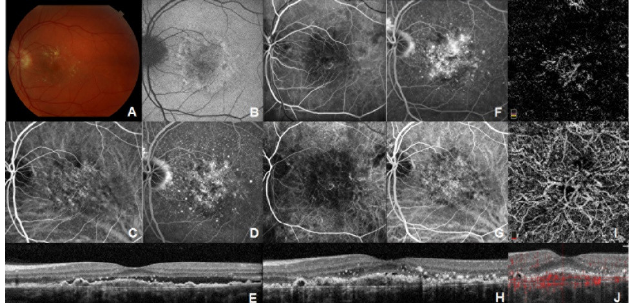
Figure 1. Multimodal imaging of one patient with subthreshold CNV. ( A ) Fundus photography of the left eye with soft drusen and pigmentary changes. Visual acuity (VA) is 20/25. ( B ) Diffuse ring of hyperautofluorescence is noted in the macula. ( C ) ICGA does not demonstrate a clear hot spot or plaque. ( D ) Late phase FA shows diffuse staining corresponding to RPE atrophy and drusen. ( E ) SD-OCT demonstrates irregular RPE elevation with overlying SRF. Fifteen months later, VA decreased to 20/70. ( F ) Early ( left ) and late ( right ) frames of FA demonstrate diffuse leakage of undetermined source in the left eye. ( G ) ICGA reveals a hypercyanascent neovascular membrane in both early ( left ) and late ( right ) phase. ( H ) SD-OCT demonstrates a fibrovascular pigment epithelial detachment (PED) with overlying hyperreflective spots and sliver of SRF. ( I ) Corresponding OCT-A of the outer retina ( top ) and choriocapillaris ( bottom ) layer shows a vascular network. ( J ) B scan on choriocapillaris layer reveals a high flow vascular network. Reprinted with permission from ref. [35]. Copyright 2020, SAGE publishing.